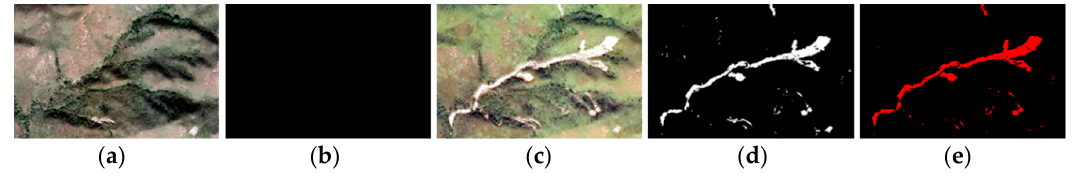
Figure 9. Landslide mapping using change detection based on image structuring information ( T 1 = 0.8, the grayscale value of the image is normalized from 0 to 1): ( a ) pre-event image; ( b ) candidate false landslide regions L pre ; ( c ) post-event image; ( d ) candidate landslide regions L post ; and ( e ) detected landslide regions according to L pre and L post , where regions marked by red color represent true landslide regions and regions marked by cyan color represent removed false landslide regions.